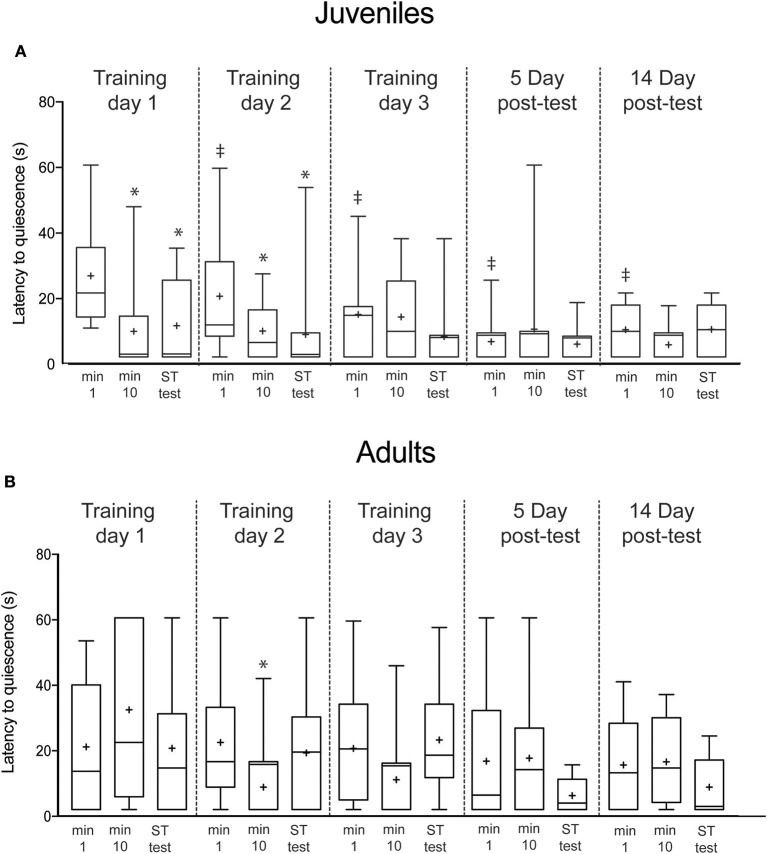
Latency to quiescence after the first, tenth and short-term test presentation of the predator mimic. (A) showed significant declines in responses from the first to last training trials on Day 1 and Day 2, and showed short-term retention on each day. Long-term memory appeared on Day 3 and was present at the 5-day interval, but not the 14-day interval. (B) Adult squid showed no sustained changes in response/nonresponse rate over the training sequence. Boxes show 25/75 percentiles, whiskers are 10–90th percentiles. Median is indicated with a line and mean with +. Statistical comparisons made with paired t-tests. Comparisons within each day (min 1 vs. min 10 or vs. test, indicating short-term memory acquired within a trial) are denoted with *. Across trial comparisons for the first minute of Day 1 vs. first minutes on subsequent days (indicating long-term memory) are denoted with ‡.